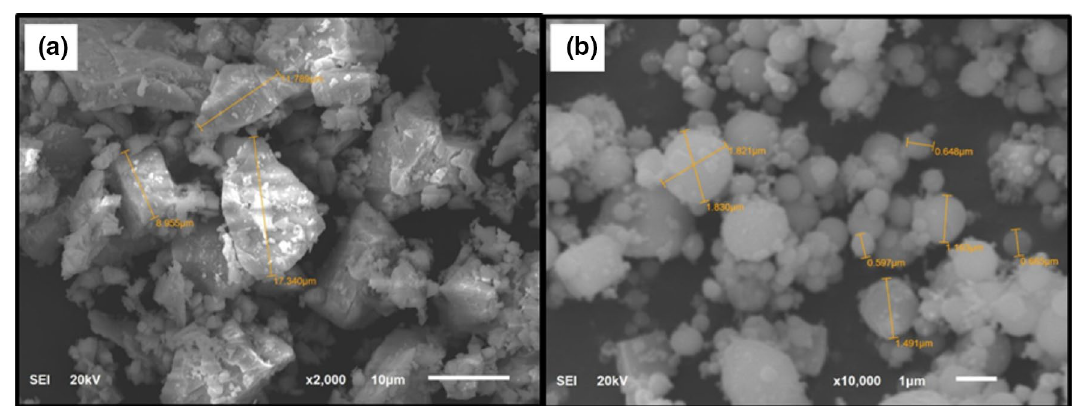
Fig. 3 Morphology of the weighting agents using SEM: a Barite and b Micromax